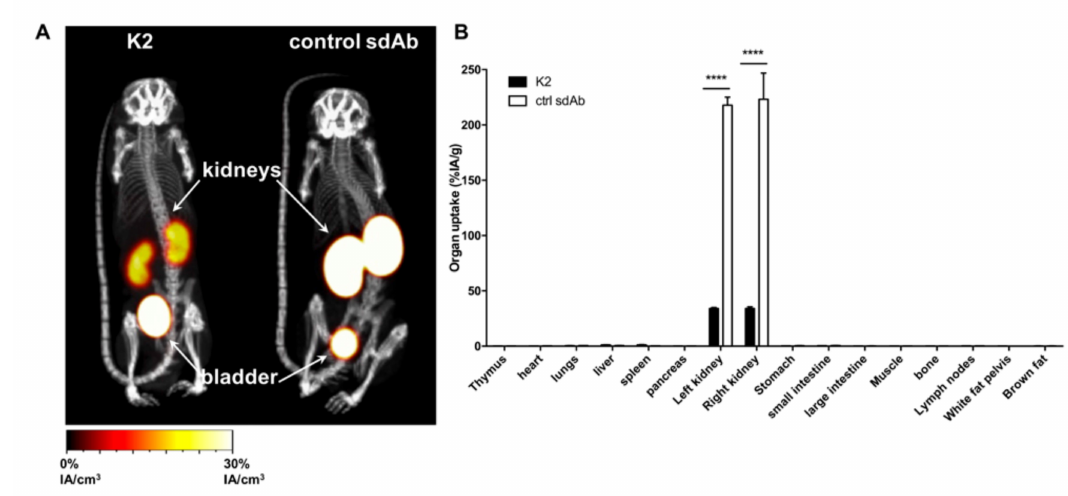
Figure 2. Radiolabeled sdAb K2 shows little signal in healthy mice. ( A ) SPECT / CT images showing the biodistribution of 99m Tc-K2 or 99m Tc-R3B23 (control sdAb) 1 h after i.v. administration in healthy C57BL / 6 mice ( n = 3). ( B ) Ex vivo analysis of the biodistribution of 99m Tc-K2 or 99m Tc-R3B23 (control sdAb) in dissected tissues and organs 80 minutes after i.v. administration in healthy C57BL / 6